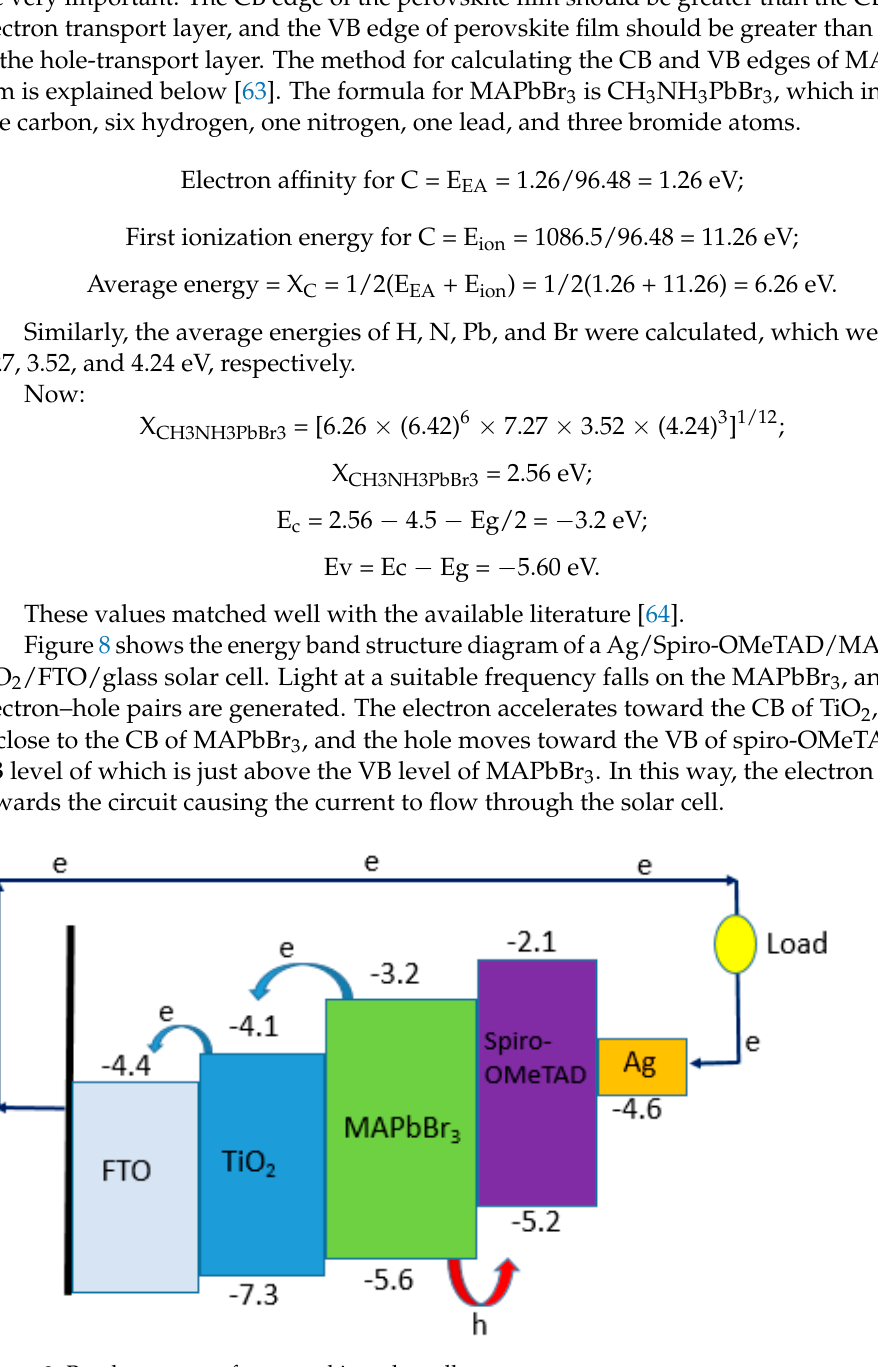
6.21 Figure 9. Current density versus voltage curves of MAPbBr 3 and Ag-irradiated MAPbBr 3. in SCOC P JVFF ×× =η